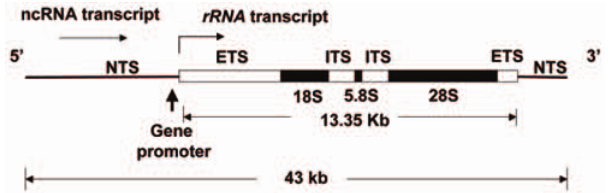
Figure 1. Repeat unit of the 45SrRNA gene (tandemly repeated in human chr. 13, 14, 15, 21, and 22). NTS: non-transcribed spacer, also known as the intergenic region; ETS: external transcribed spacer; ITS: internal transcribed spacer. rRNA transcription starts at the 5 9 end of the ETS, with the first 414 nucleotides comprising the leader sequence. The non-coding (nc) r-RNA transcript is initiated upstream of the ETS.